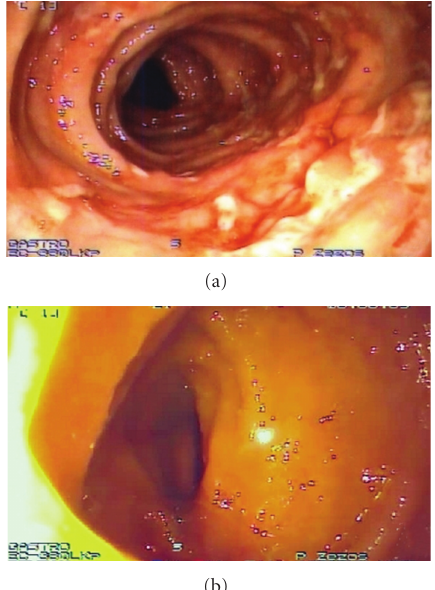
Figure 1: Colonoscopy demonstrated active colitis with longitu- dinal ulcers from sigmoid colon through cecum (a) and a normal terminal ileum (b).